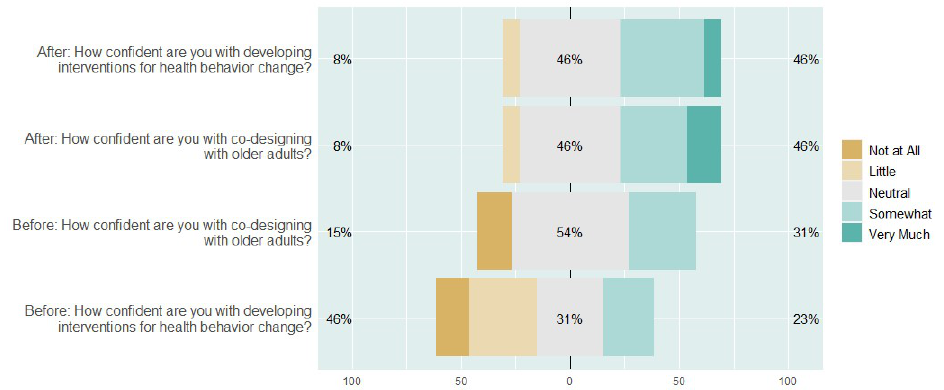
Figure 5. Confidence levels before and after the hackathon ordered by Strongly Disagree (from not at all to very much).